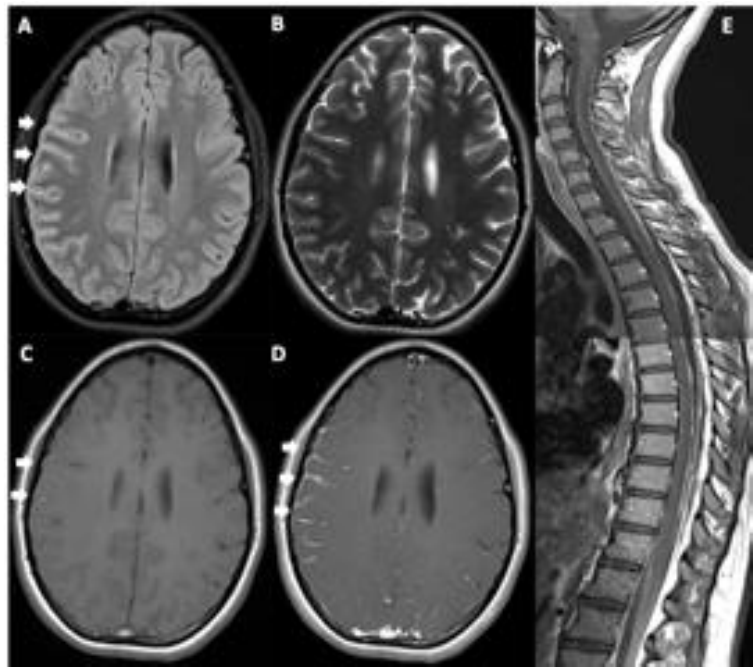
Figure 1. Brain MRI (( A – D ), axial images) and spine (( E ), sagittal Gd T1w image). Brain MRI shows diffuse leptomeningeal hyperintensity in the FLAIR image (arrows, ( A )), not appreciable in the T2w image ( B ), with discontinuous mild spontaneous T1w hyperintensity (arrows, ( C )) and diffuse leptomeningeal contrast-enhancement (Gd T1w, arrows, ( D )). It is also appreciable diffuse spinal leptomeningeal contrast-enhancement ( E ).